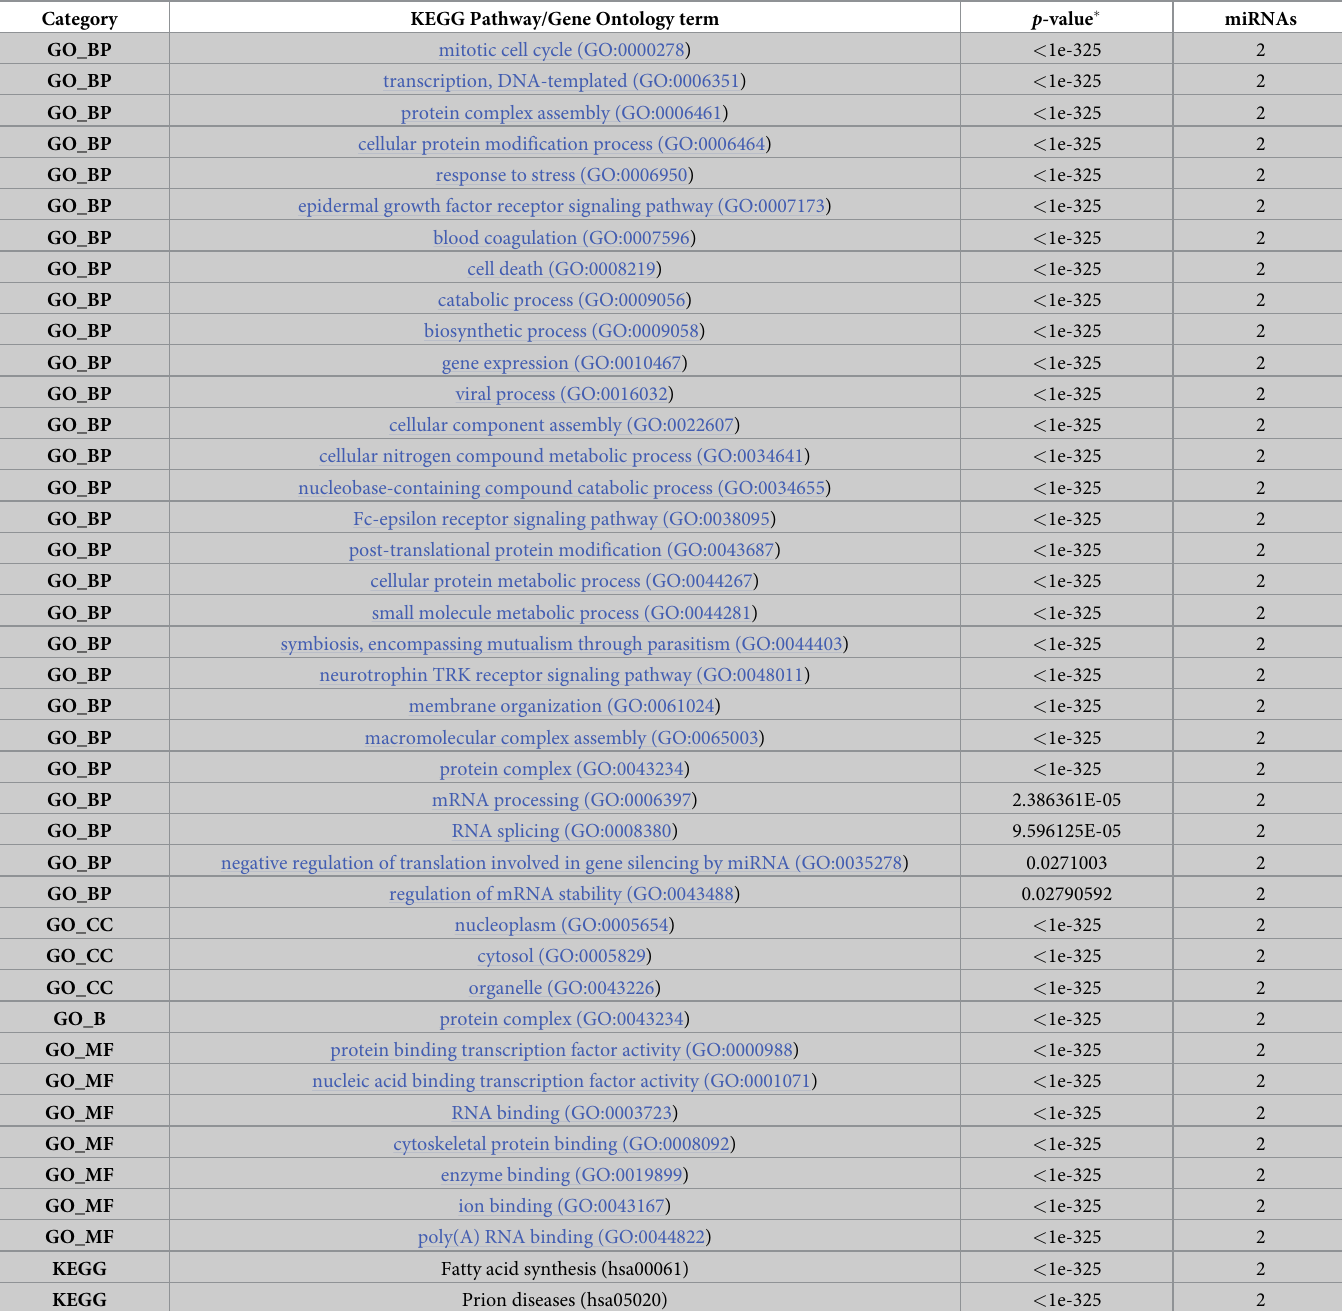
Table 3. Functional enrichment analysis of miR-27a-3p and miR-27b-3p.